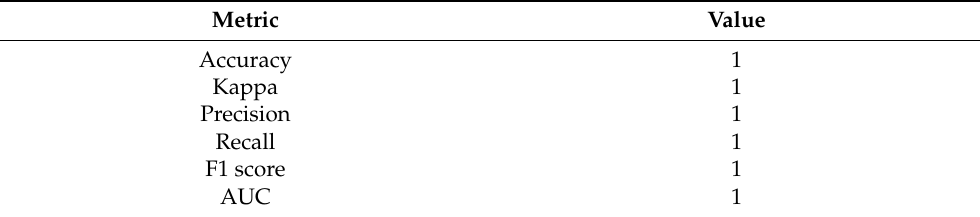
Figure 7. ROC curve of each class on test set. Table 3. Performance indicators of multi-class classification on a test